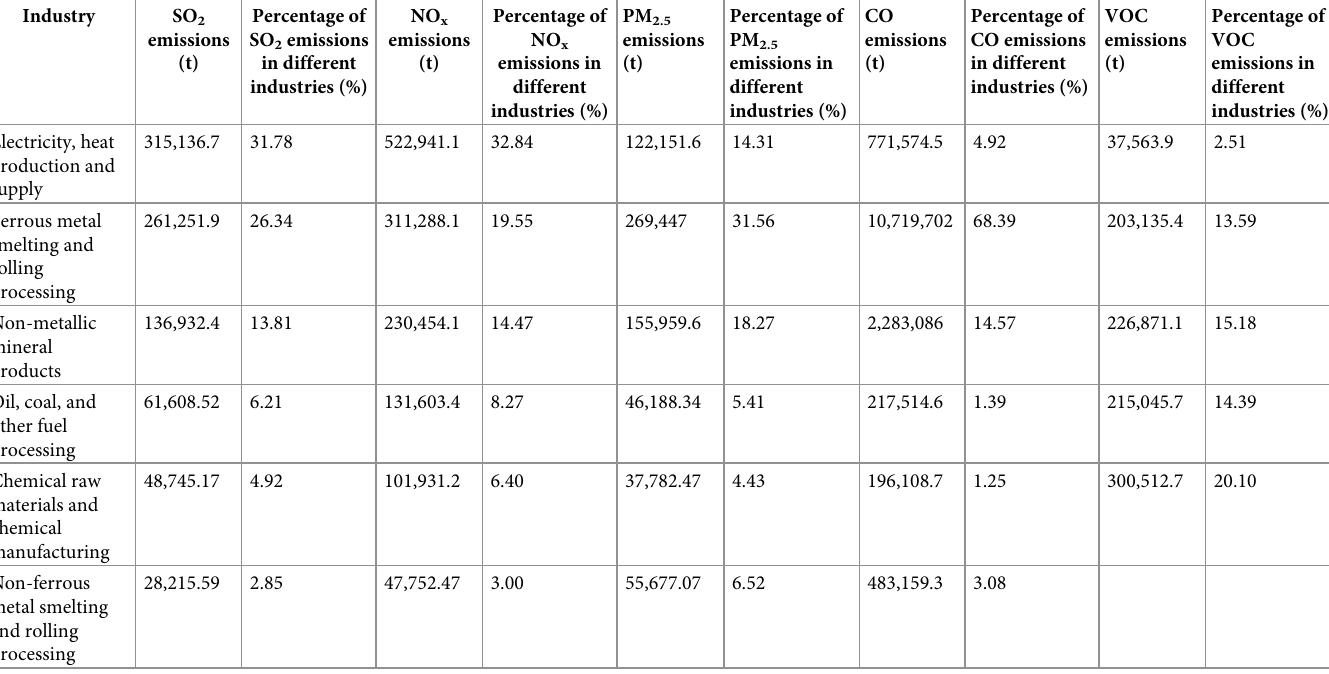
Table 5. Pollutant emissions from different industries of BTH “2+26” cities in 2016.